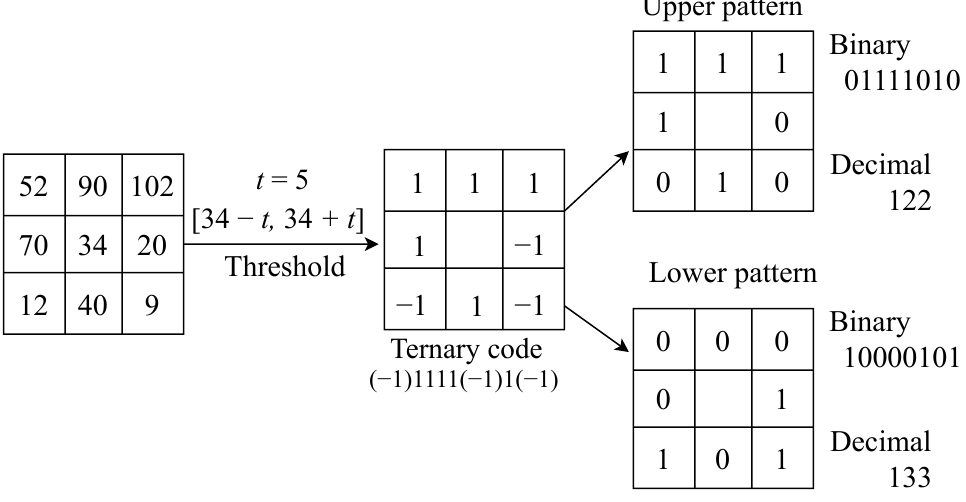
Figure 2. Describes the encoding of the LTP